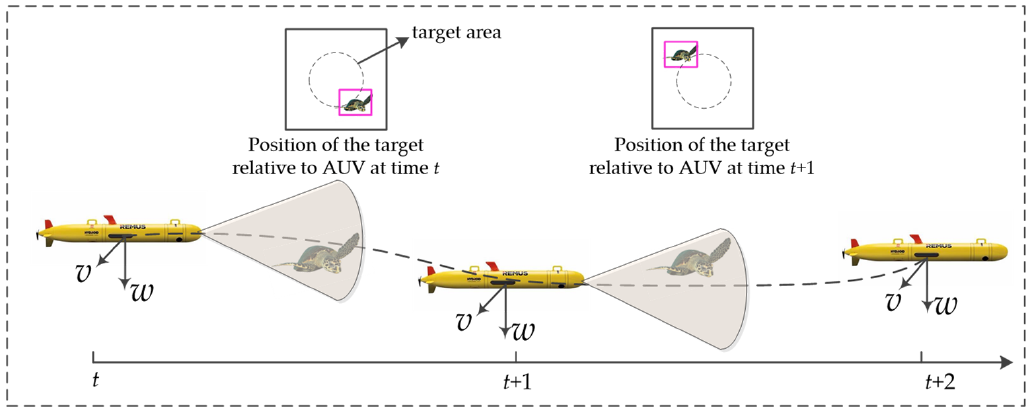
Figure 2. The schematic diagram of AUV dynamic target tracking. The tracked target motion is time-varying. p is defined as a constant, which represents the probability of the tracked target changing its motion direction and speed. The mag- nitude of motion change follows normal distribution. Considering the upper and